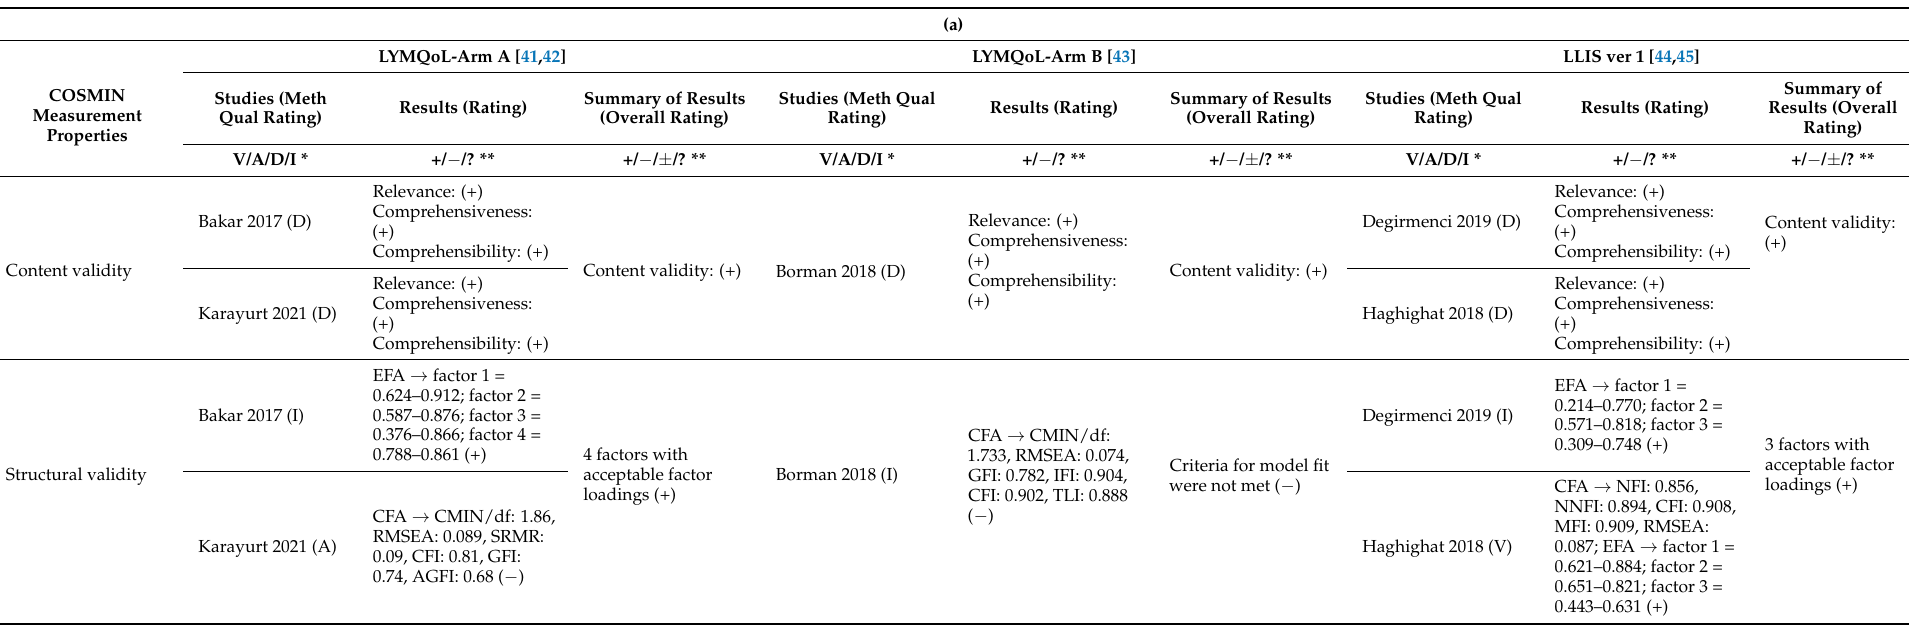
Table 5. ( a ) COSMIN ratings on methodology quality and results per measurement property. ( b ) COSMIN ratings on methodology quality and results